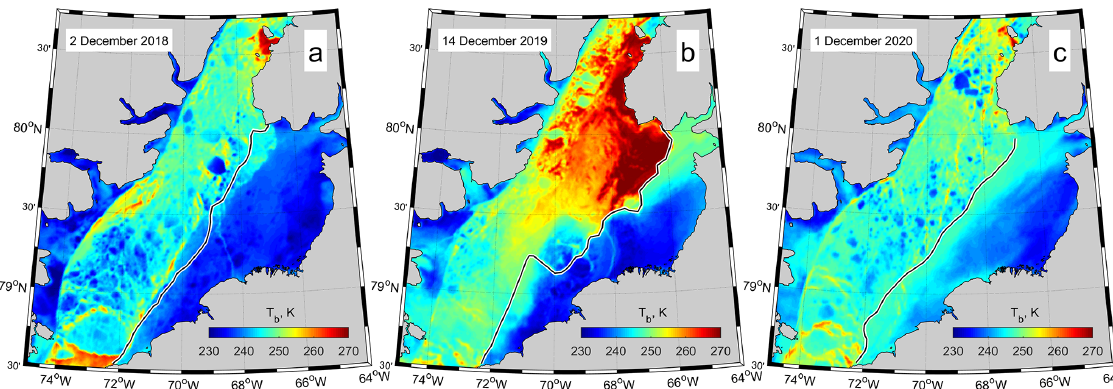
Figure 10. MODIS clear-sky brightness temperatures on (a) 2 December 2018, (b) 14 December 2019 and (c) 1 December 2020. Images (b) and (c) show T b several days prior to ice bridge formations in both years. The black lines indicate approximate positions of the landfast ice edge at the date of each